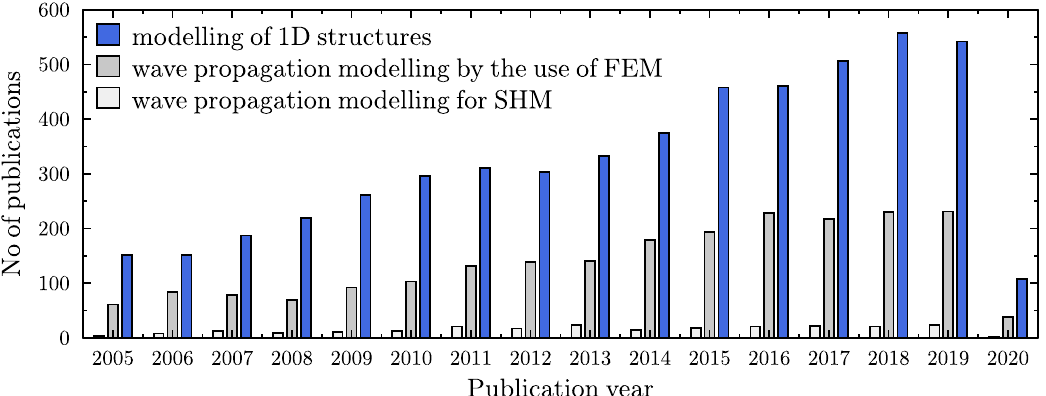
Figure 2. Graphic summary of the number of publications, related with modelling of 1D elements. Web of Science (26 March